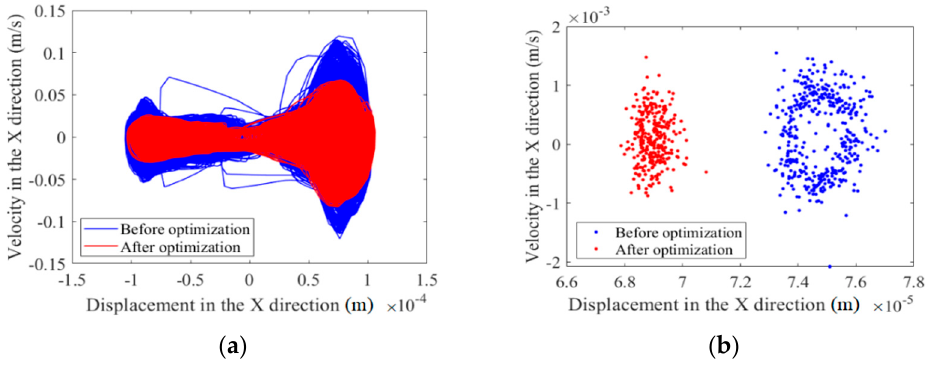
Figure 9. Nonlinear characteristics of joint B in the X direction. ( a ) Phase map. ( b ) Poincar é